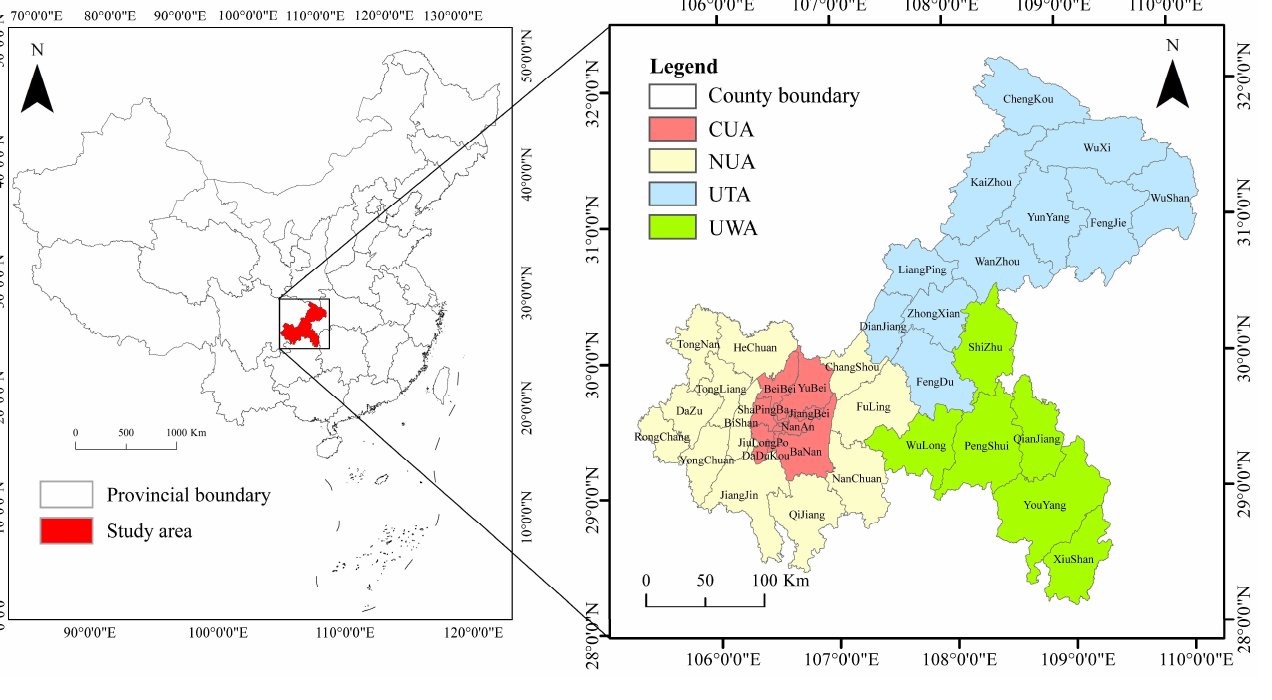
Figure 1. Map of the research area.